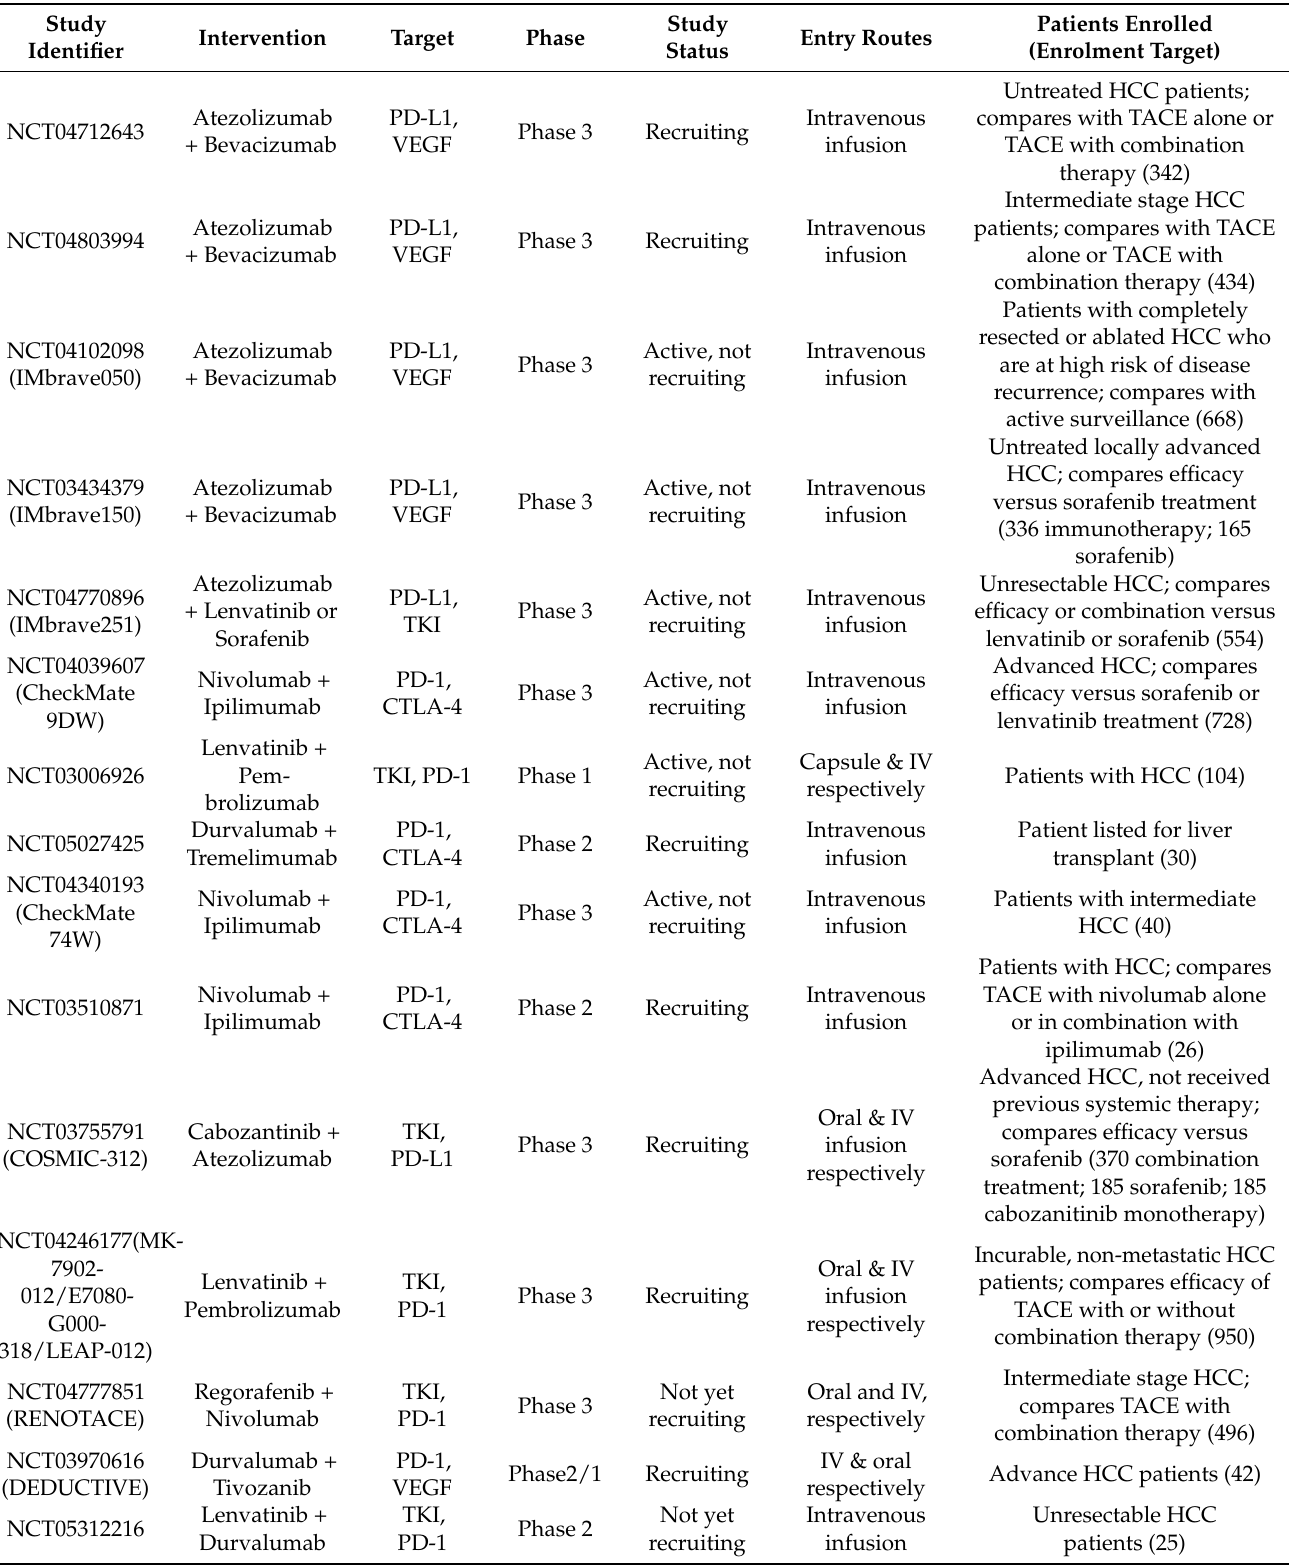
Table 4. Data from https://www.clinicaltrials.gov/ accessed on 10 May 2022 showing clinical trials of combinational immunotherapy (immune checkpoint inhibitor) for the treatment of advanced hepatocellular